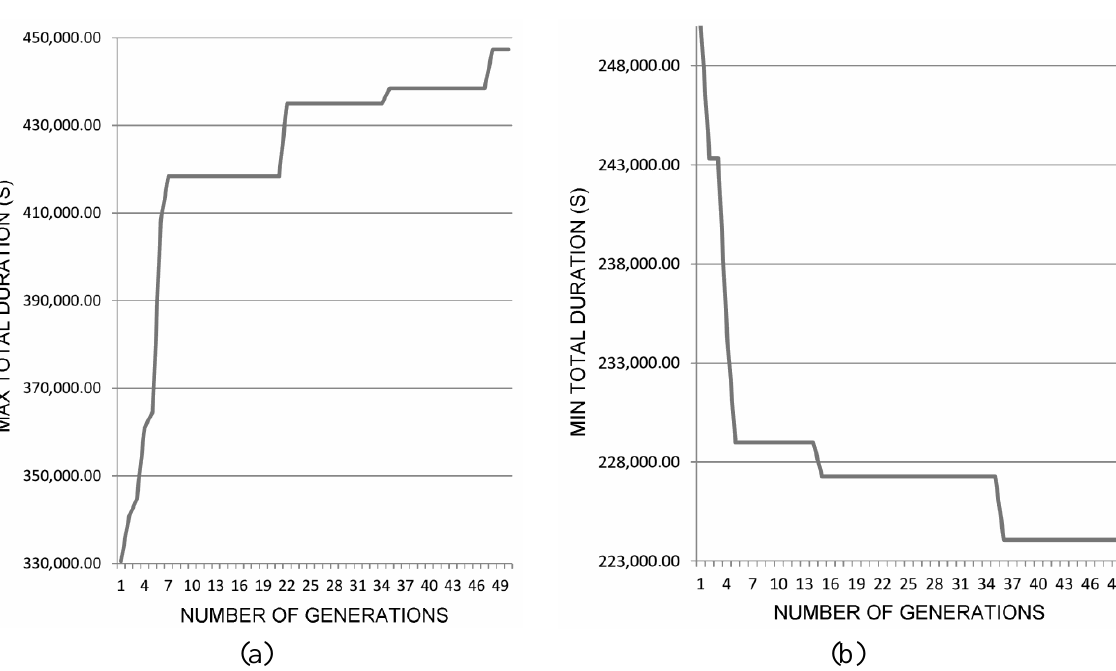
Figure 15. Total duration vs. number of generations for the hospital process.